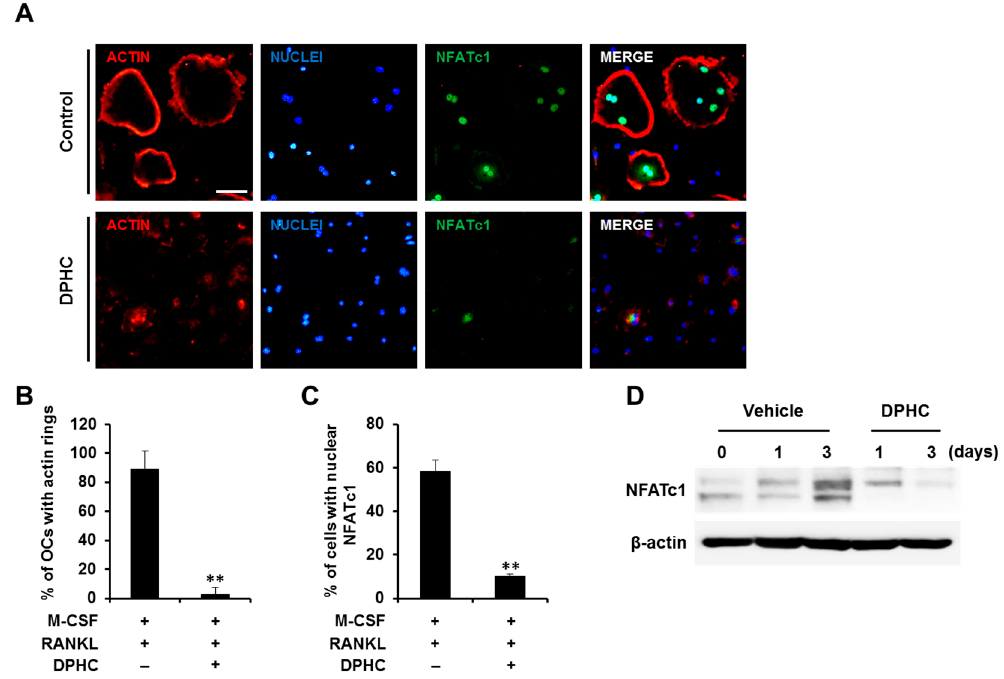
Figure 3. Effects of DPHC on actin ring formation and NFATc1 expression. ( A ) BMMs were cultured on glass coverslips in osteoclastogenic media with vehicle or DPHC (75 μ g/mL) for four days. Further, the cells were labeled with anti-NFATc1 antibody, followed by phalloidin and 4 ′ ,6-diamidino-2-phenylindole (DAPI) staining; scale bar, 50 μ m; ( B ) The number of actin rings per bone slice and ( C ) the number of cells with nuclear NFATc1 were counted; ** p < 0.01 versus vehicle-treated control; ( D ) BMMs were cultured in osteoclastogenic media in the absence or presence of DPHC (75 μ g/mL) for the indicated durations. NFATc1 protein levels in the cell lysates were analyzed by western blotting.